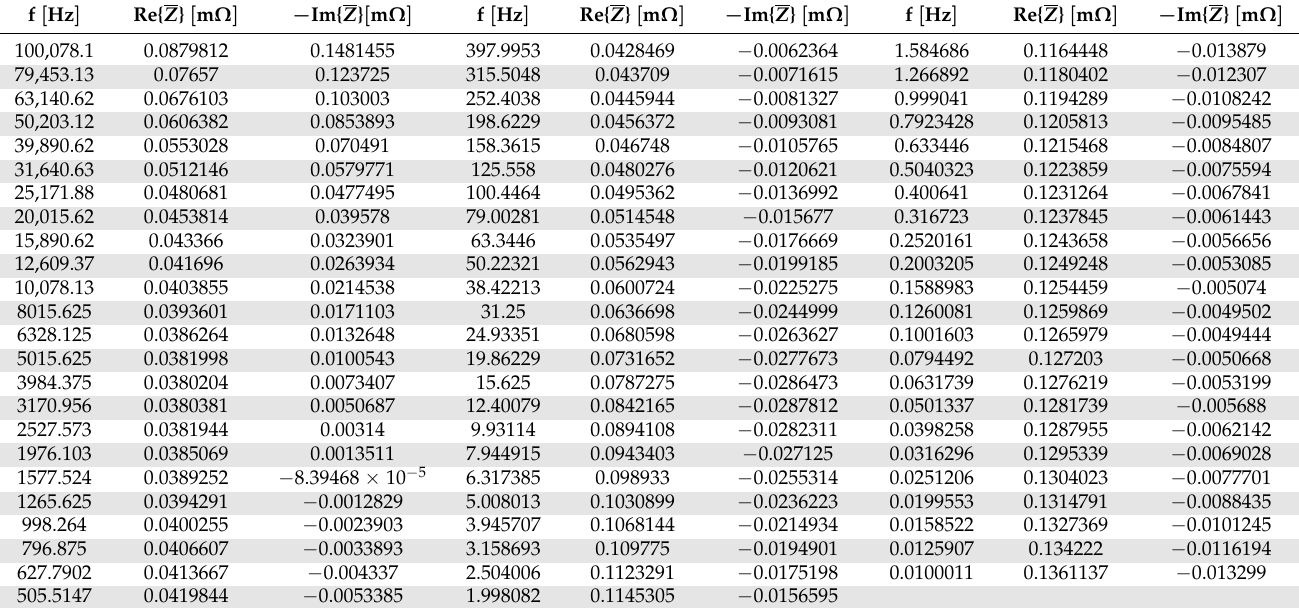
Table A8. EIS data for Sanyo ZT at an SOC of 50%.